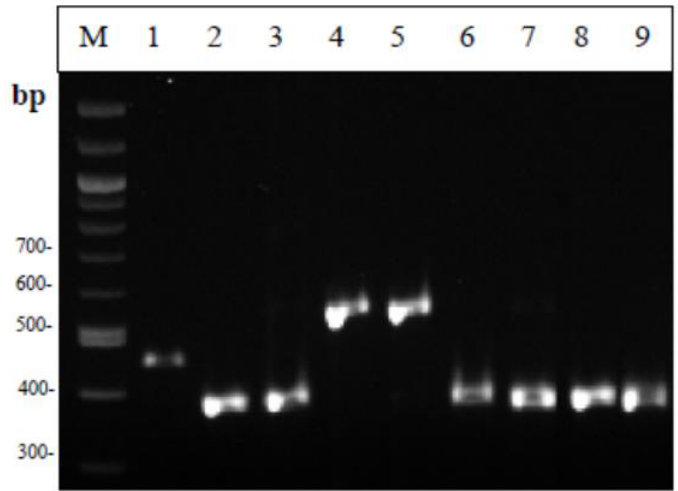
Figure 2. Results from the Multiplex PCR identifying the four genera Lactococcus, Lactobacillus, Streptococcus and Leuconostoc. M: 100 bp DNA ladder, 1: Streptococcus thermophilus LMG 13565, 2: Lactococcus lactis DSM 0718, 3: Lactococcus garvieae subsp. garvieae DSM 20684, 4: Leuconostoc pseudo-